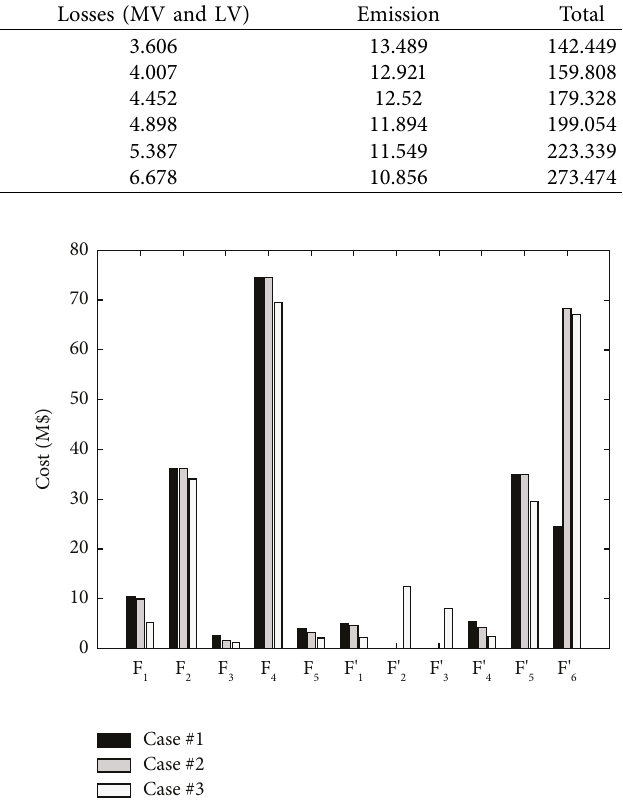
Figure 10: Comparison of the cost components in MV and LV